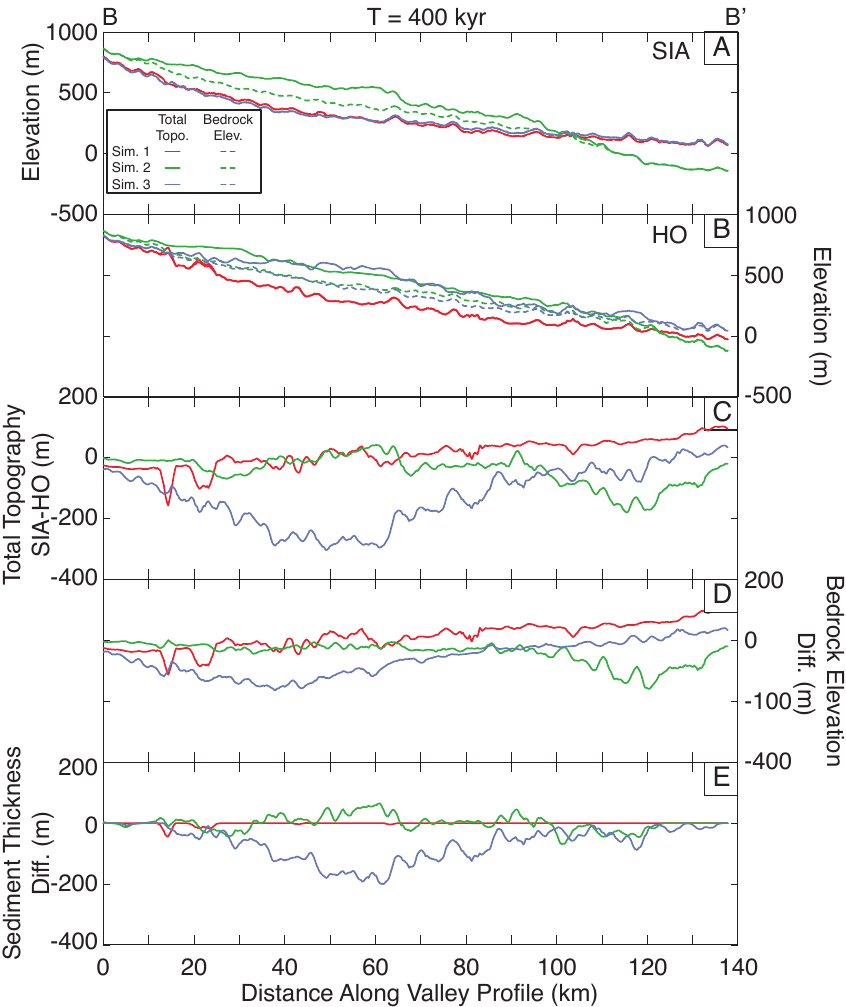
Figure 10. (a–c) Topographic profiles following the B–B’ valley profile (Fig. 1). Solid lines indicate the ice-bed topography contact, and the dashed lines indicate the bedrock elevation (sediment is allowed to accumulate in ICE-Cascade). (a) SIA topographic profiles at the end of the full simulation. (b) HO topographic profiles at the end of the full simulation. (c) Differences between the topographic profiles erosion rates (SIA–HO). (d) Differences between the bedrock topography (SIA–HO). (e) Differences between the sediment thicknesses